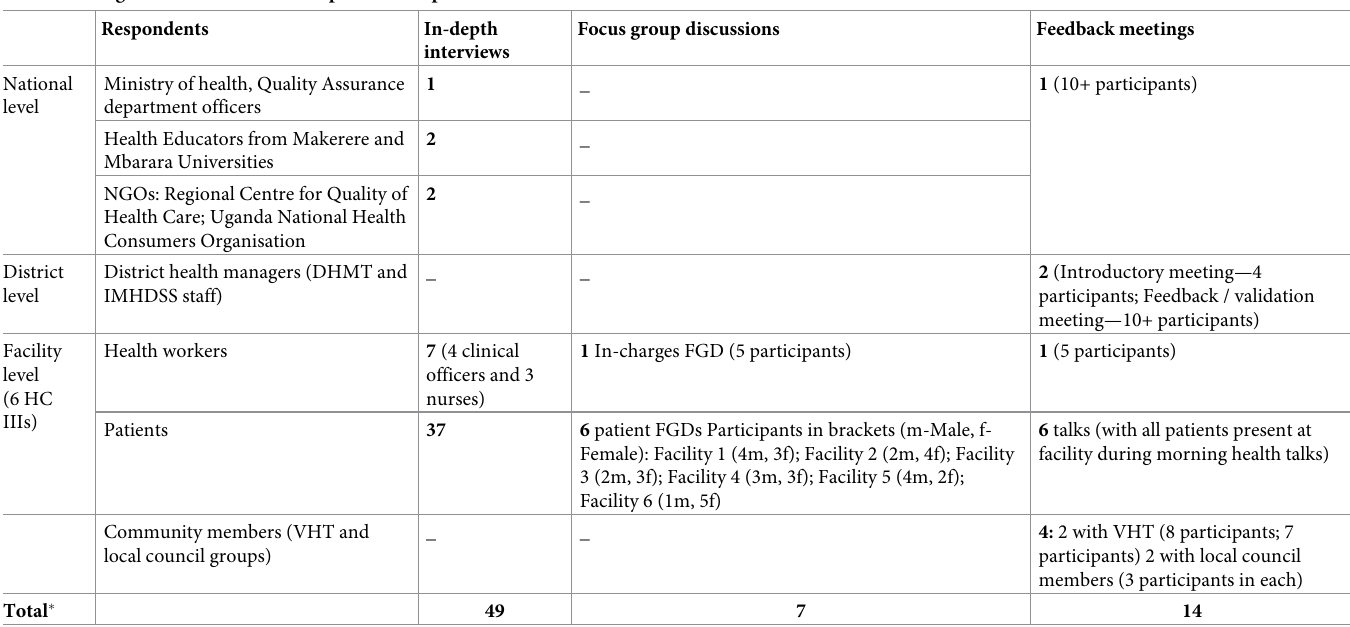
Table 3. Categories and numbers of respondents as per data collection